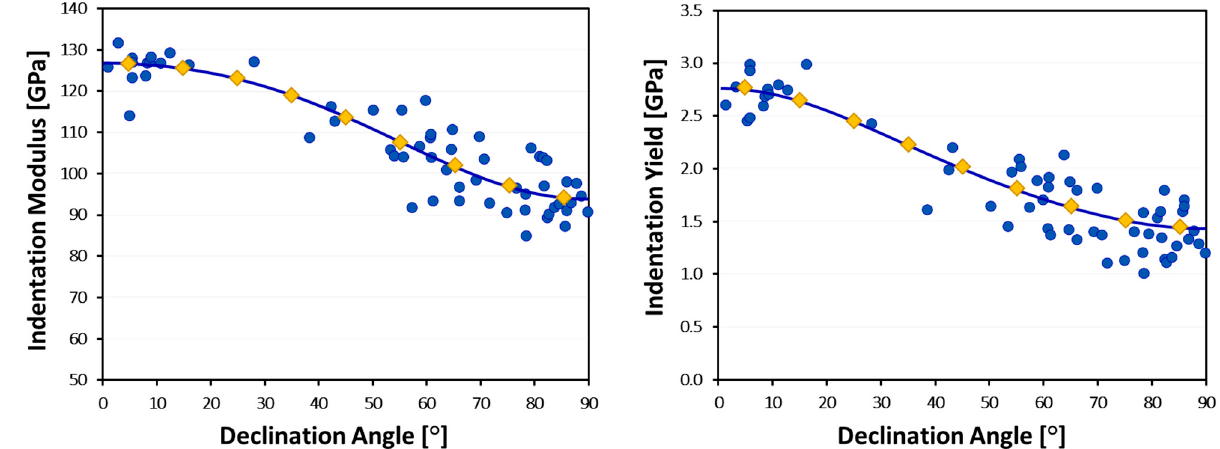
Figure 4. Examples of the indentation stress-strain curves measured in this study. The blue curves are from measurements on primary a grains, the green curves are from basket-weave grains, and the pink curves are bulk measurements.